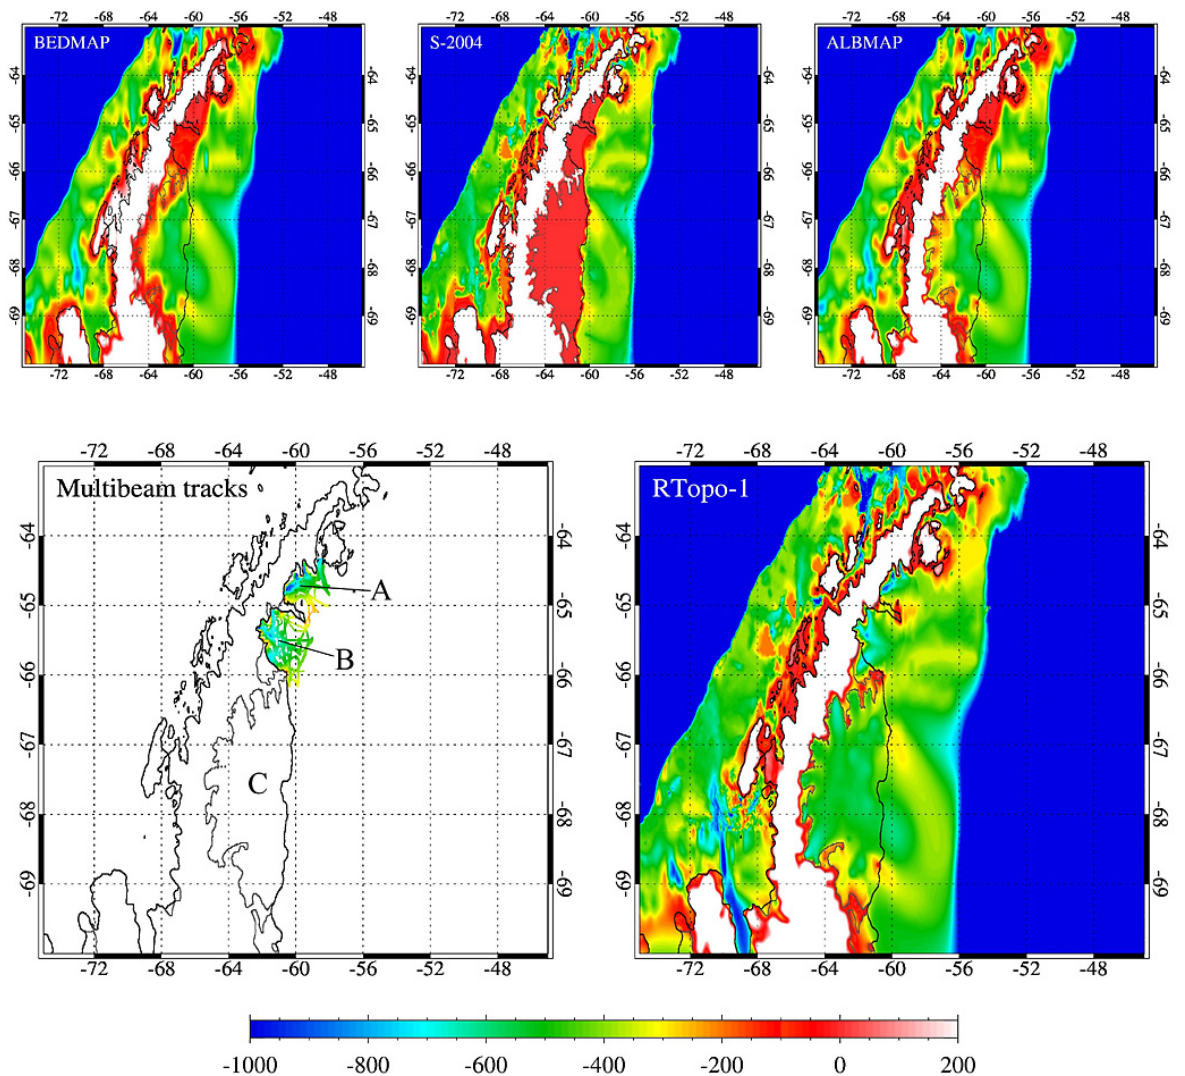
Figure 5. Di ff erent representations of bathymetry (bedrock topography) in the area of the Larsen Ice Shelves. Top row: BEDMAP (left), S-2004 (middle), and ALBMAP (right). Bottom row: Multibeam track data (left), and the RTopo-1 product (right). Ice shelf front and coastline are marked with a black line, grounding line location with a grey line. The letters A / B / C mark the (former) Larsen A, B and C Ice Shelf